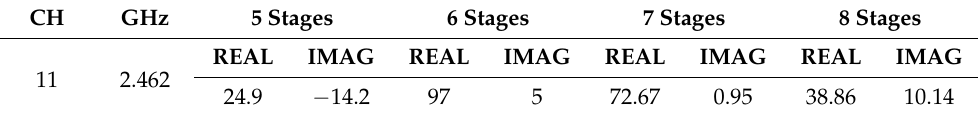
Table 4. Impedance of multipliers of 5, 6, 7, and 8 stages for Channel 11.